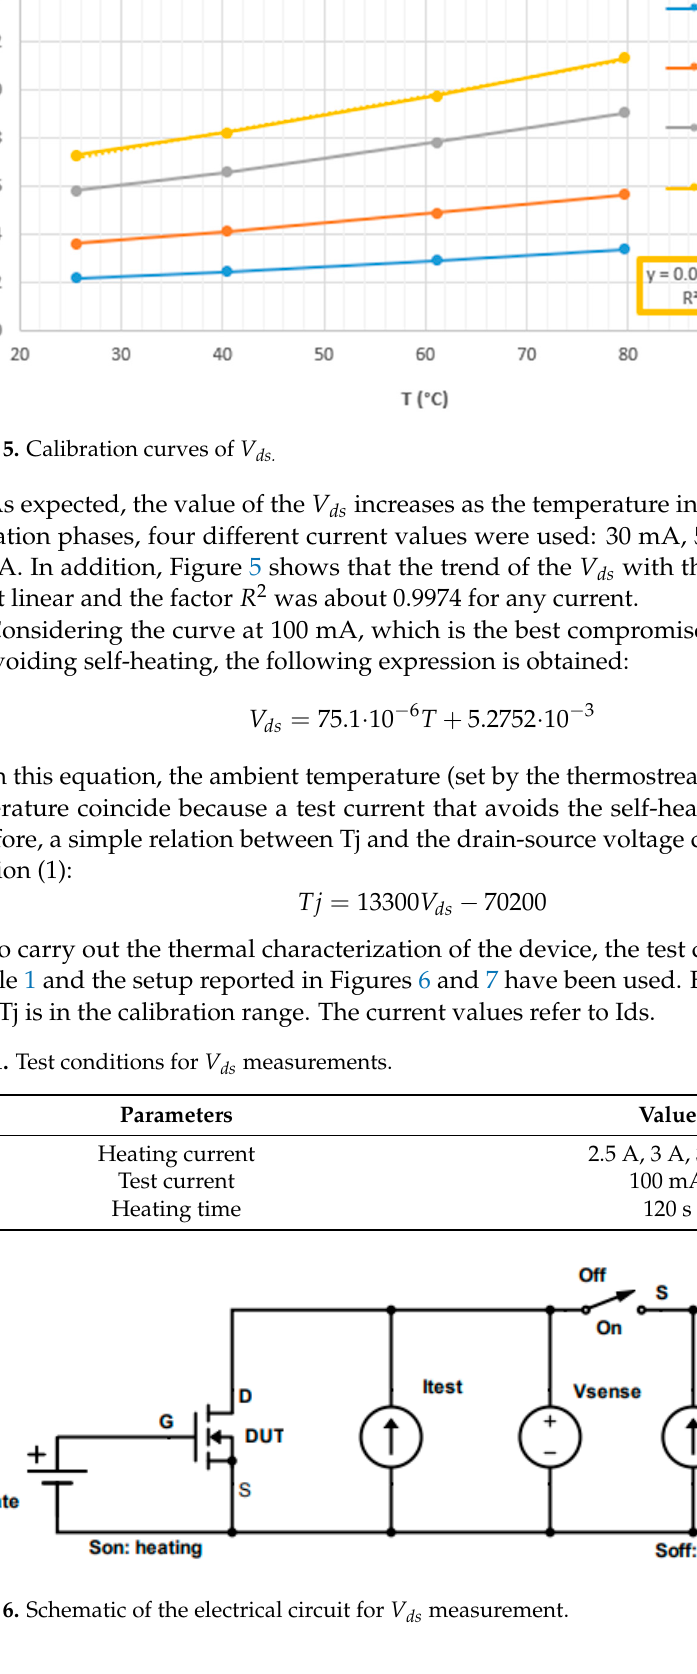
Figure 4. The device under the airflow.